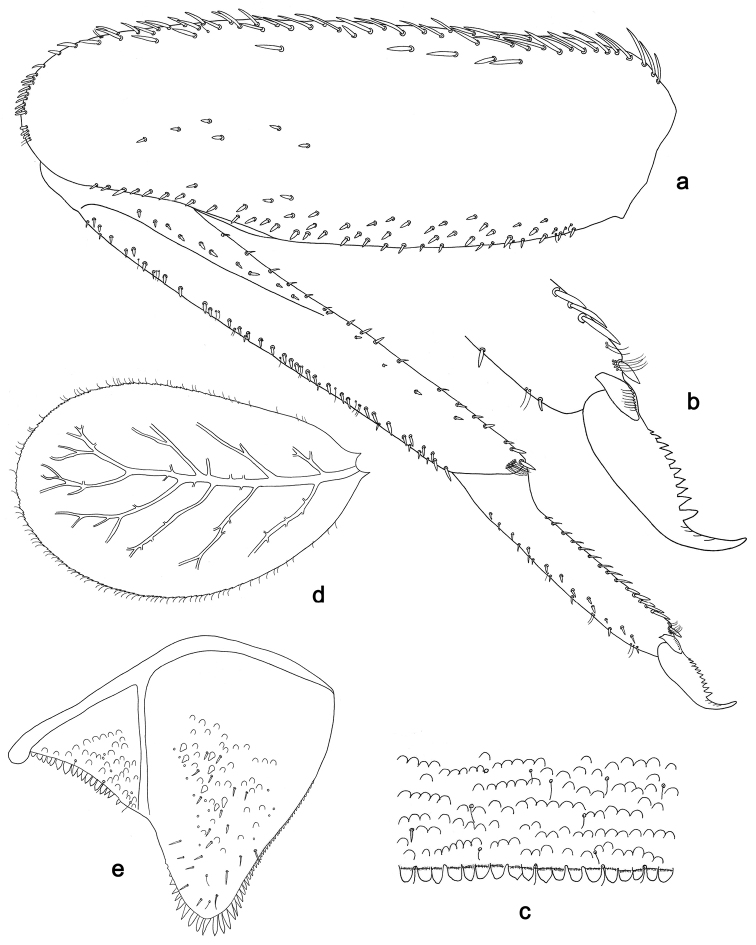
Labiobaetisrutschmannae sp. n., larva morphology: aForelegb Fore claw cTergum IV d Gill IV eParaproct.